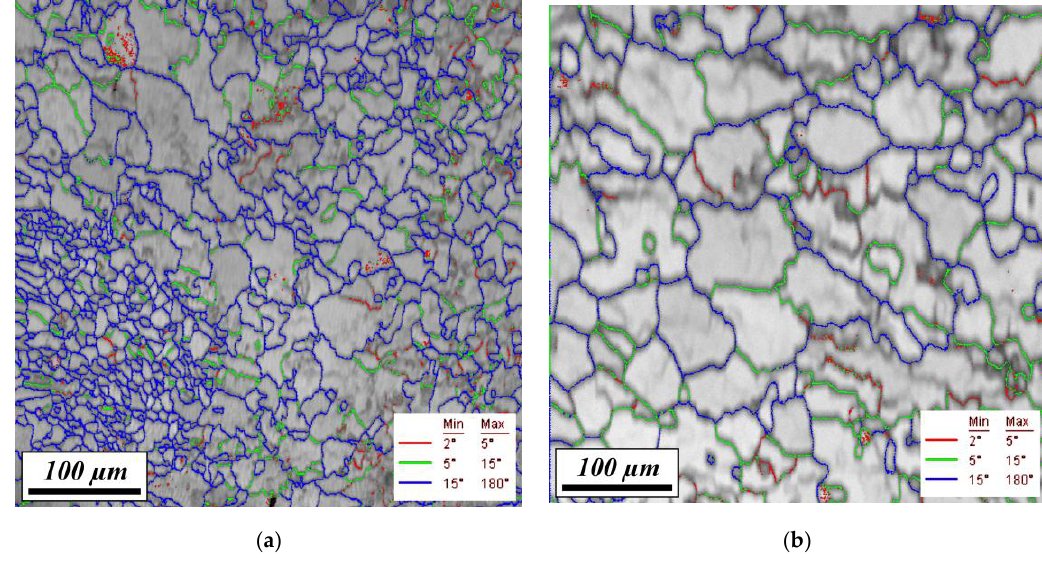
Figure 5. Misorientations between adjacent grains. Three misorientation classes are highlighted as indicated. Grain boundaries with misorientations smaller than 2° are not highlighted: ( a ) SEBM Specimen A; and ( b ) SEBM Specimen B.